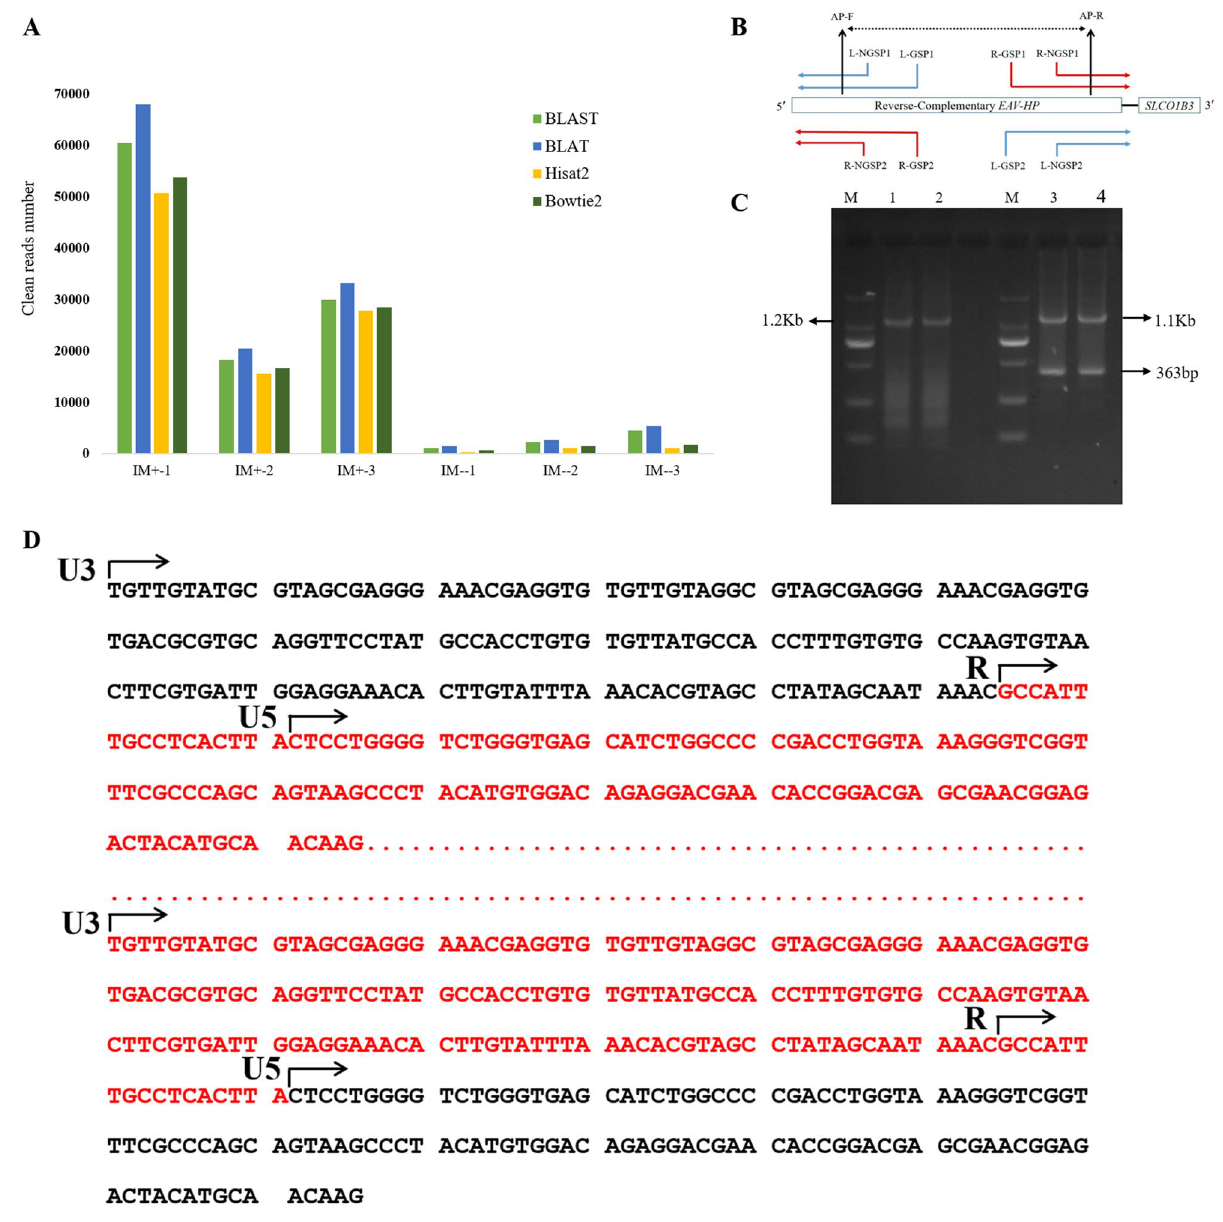
Figure 5. A new EAV-HP transcript highly expressed in the liver tissues of IM+ chickens. ( A ) EAV-HP alignment results from the RNA-seq data. y-axis represents the mapped clean read number for each individual library. BLAST, BLAT, Hisat2 and Bowtie2 are four different R packages used to align the EAV-HP sequence. The different software packages have different features and were used to obtain consistent results. (B ) The EAV-HP transcript RACE primers design model. The blue colored RACE primers were designed to clone the EAV-HP transcript transcription start site from the left orientation, and the red color from the right orientation. ( C ) RACE gel results of the EAV-HP transcript, the gel cropped from same part of the same gel and the full-length gel are given in the Fig. S4, 1, 2 indicate the R-5 ʹ RACE nested PCR results; 3, 4 indicate R-3 ʹ RACE nested PCR results. The short fragment (363 bp) for 3 ʹ RACE was a false positive from the later sanger sequencing. ( D ) The transcriptional start and end site of the EAV-HP transcript. The red colored sequence is the full-length EAV-HP transcript sequence, and the red dots represents the omitted gag and env sequences, U3, R and U5 are the parts of long terminal region (LTR) of EAV-HP